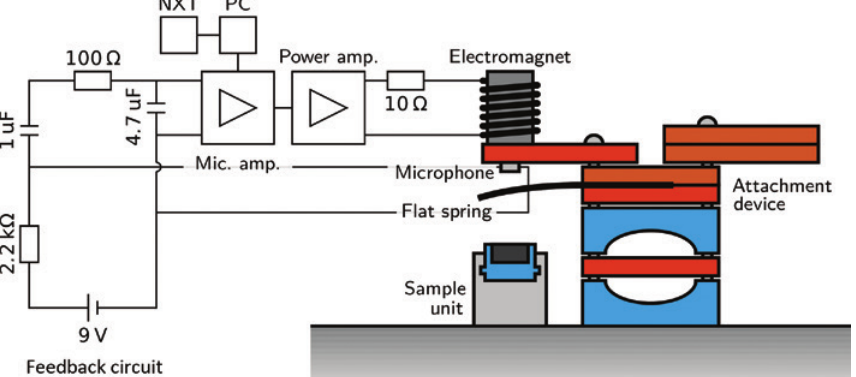
Figure 4: Sketch of microscope unit and feedback circuit as part of the macroscopic MFM model (blue = 3D-printed material, orange = brass, light gray = LEGO).